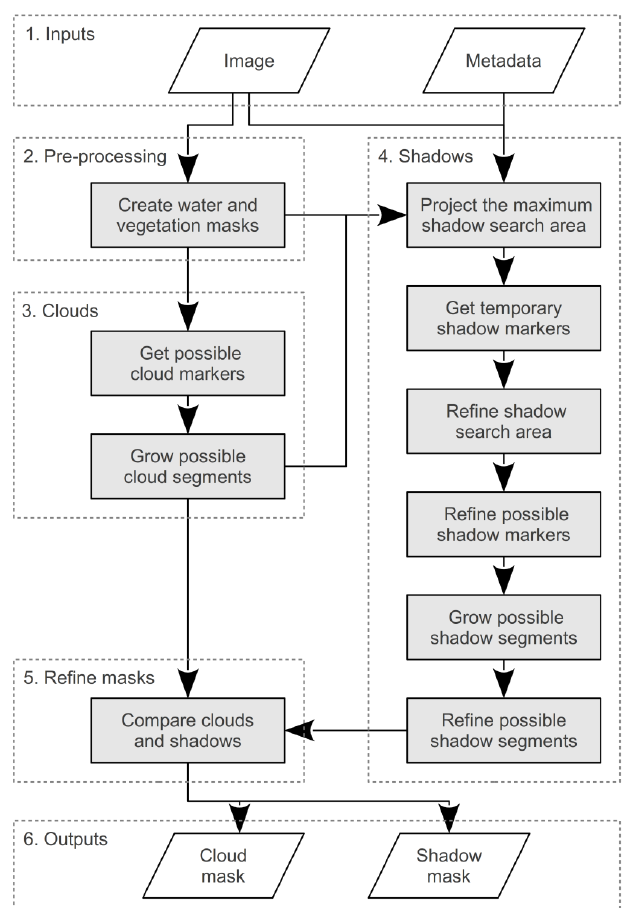
Figure 5. The six main steps of the SPOTCASM